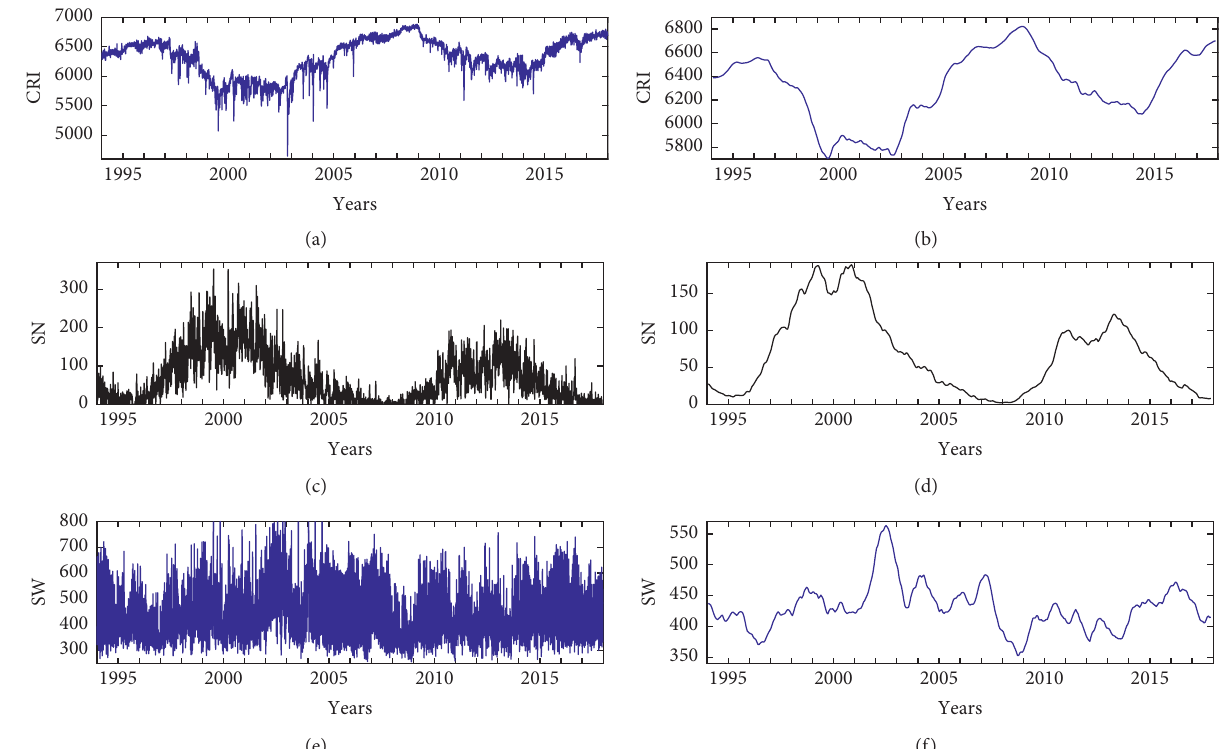
Figure 1: The daily distributions and the trends for the sunspot numbers, cosmic ray intensity, and the solar wind speed. The trends reveal the modulations and the long-term responses of the cosmic ray intensity and the solar wind speed to the sunspot numbers. The cosmic ray intensity shows periodicity around 11-year solar cycle while the solar wind speed shows irregular modulations in response to the solar activities. (a) Cosmic ray intensity daily distribution.(b) Cosmic ray intensity trend. (c) Sunspot numbers daily distribution. (d) Sunspot numbers trend. (e) Solar wind speed daily distribution. (f) Solar wind speed